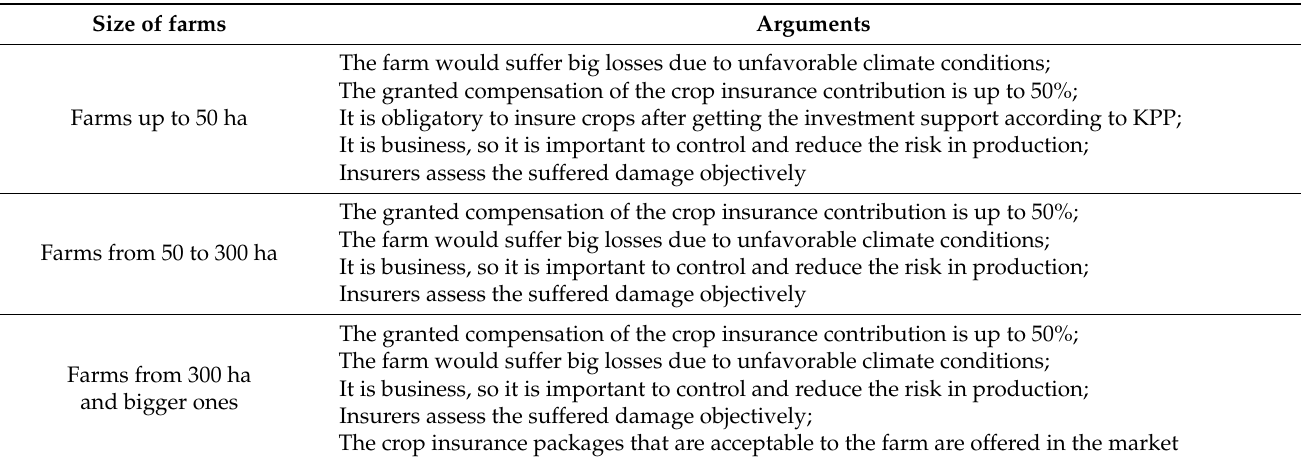
Table 4. Reasons that encourage farms to insure crops.